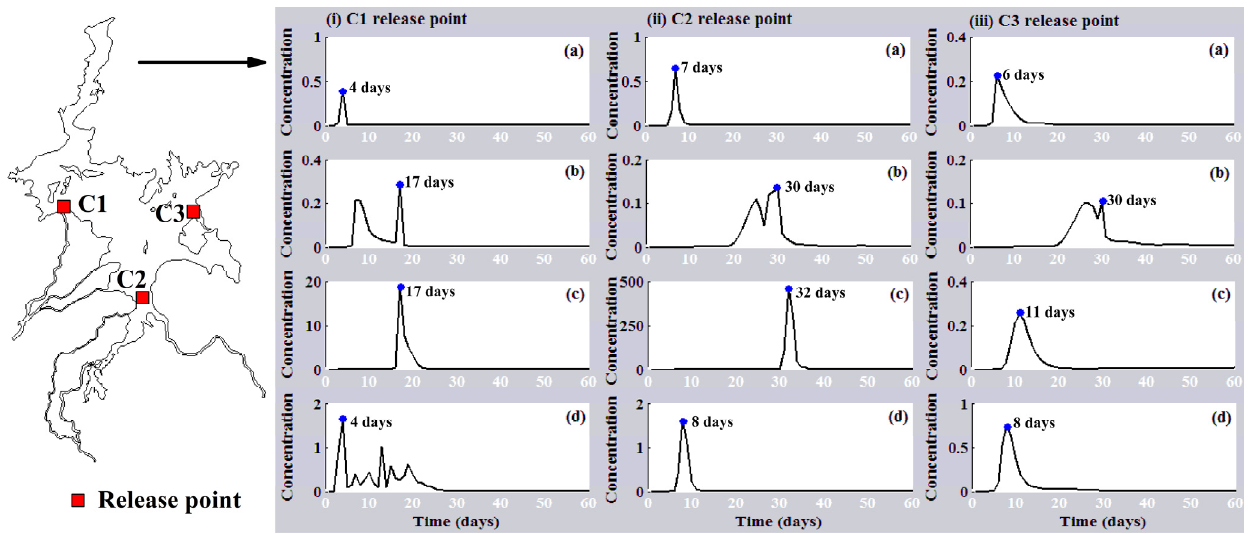
Figure 15. Time series of tracer concentrations at the Hukou lake outlet (concentrations after 60 days are not shown due to low values). Releases were performed during ( a ) the water level rising period on the 1st of April during the spring; ( b ) the high water level period on the 1st of July during the summer; ( c ) the water level recession period on the 1st of October during the autumn; and ( d ) the low water level period on the 1st of January during the winter. Here, time represents the time elapsed since the release. The blue dot represents the peak concentration and the associated travel times that are defined in this study. A unit dye concentration of 10 − 4 kg/m 3 was